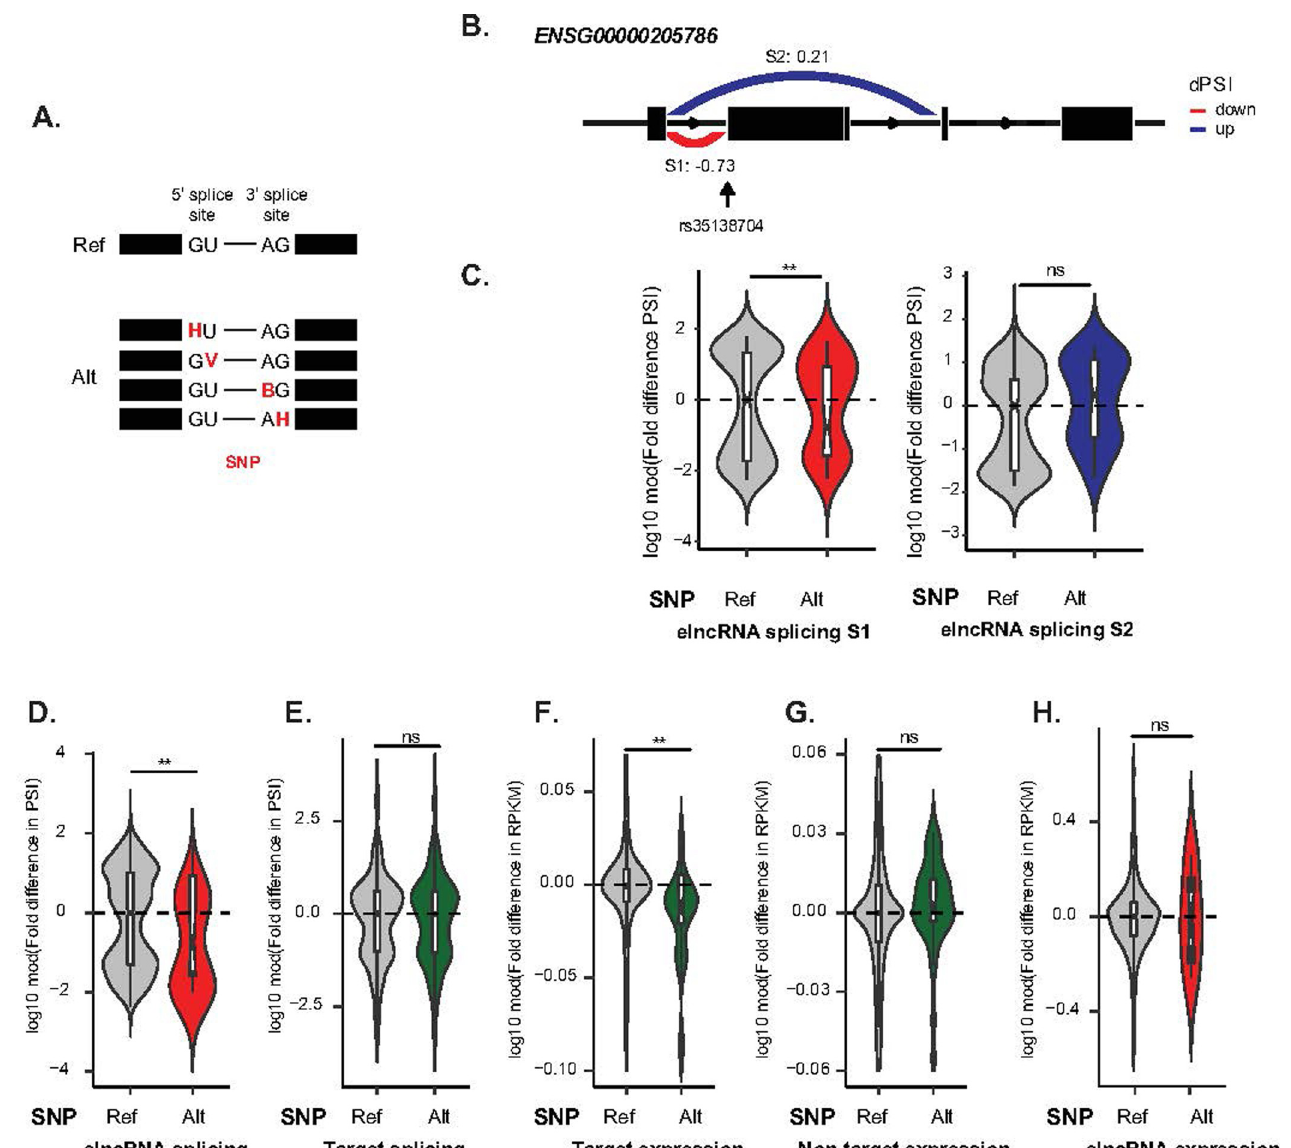
Fig 2. Disrupted elncRNA splicing impacts cis -gene regulation. (A) Examples of variants that can disrupt elncRNA splicing. In contrast to individuals that carry the reference genome allele at a canonical splice site, those with alternative alleles have at least one variant that disrupt the GU dinucleotide at splice donor site (denoted as HU or GV) or AG dinucleotide at splice acceptor site (denoted as BG or AH). (B) Representation of the differential splicing events between samples with different genotypes for one elncRNA, ENSG00000205786. Median differential splicing (log10 modulus fold difference in Percentage-Spliced-In (dPSI)) of each splicing event is noted next to the arrow. Decreases are represented in red and increases represented in dark blue. (C) Distribution of the log10 modulus fold difference in PSI, relative to the median of samples with reference genotype, between individuals that carry alternative or reference alleles at each corresponding elncRNA splicing event as shown in (B). (D-H) Distribution of the log10 modulus fold difference in splicing (PSI), relative to the median of samples with reference genotype, between individuals that carry alternative or reference alleles at elncRNA splice site of ENSG00000205786, of all directly affected splicing events of (D) the elncRNA and (E) all splicing events of its target protein coding genes (5 targets); as well as fold difference in expression levels (RPKM) of (F) targets, (G) non-targets and (H) the elncRNA. Differences between groups were tested using a two-tailed Mann-Whitney U test. � p < 0.05; �� p < 0.01; ��� p < 0.001; NS p >